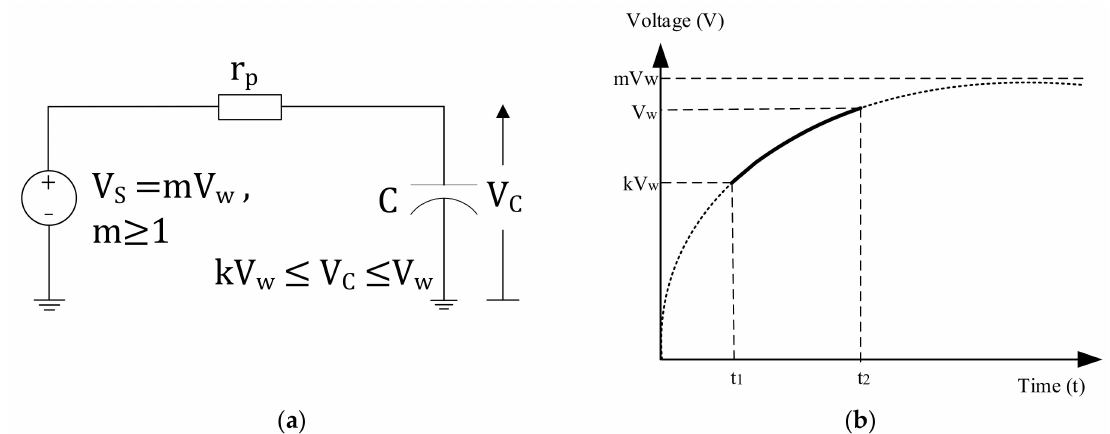
Figure 3. Figure 2a modified by inserting a pre-charged supercapacitor: ( a ) longer time constant RC circuit achieved by inserting a supercapacitor; ( b ) charging curve of the supercapacitor from pre-charge voltage (kV W ) to working voltage (V W ), which is below power supply voltage mV W